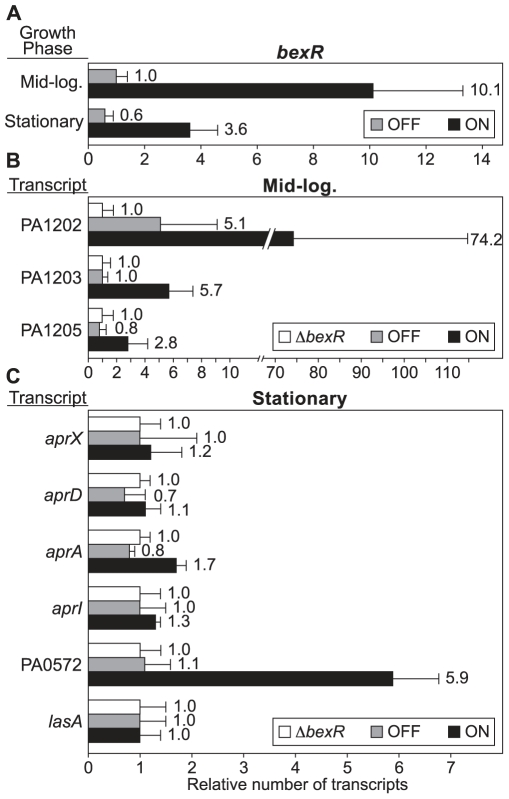
BexR-regulated transcripts vary between the OFF and ON states.(A) Relative quantity of bexR mRNA in both mid-logarithmic and stationary phase. (B) Relative quantities of PA1202 operon mRNAs in mid-logarithmic phase. (C) Relative quantities of quorum sensing-regulated mRNAs in stationary phase. Error bars represent relative expression values calculated from +/−1 SD from the mean ΔΔCt.